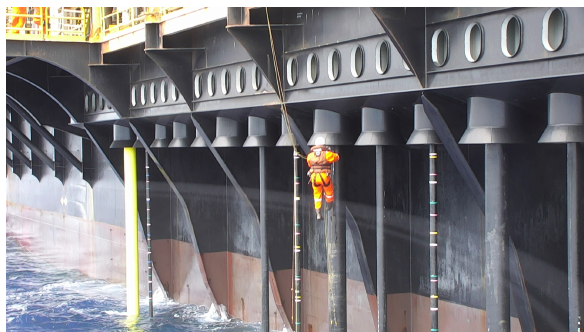
Figure 1. Industrial climbers inspecting the emerged riser